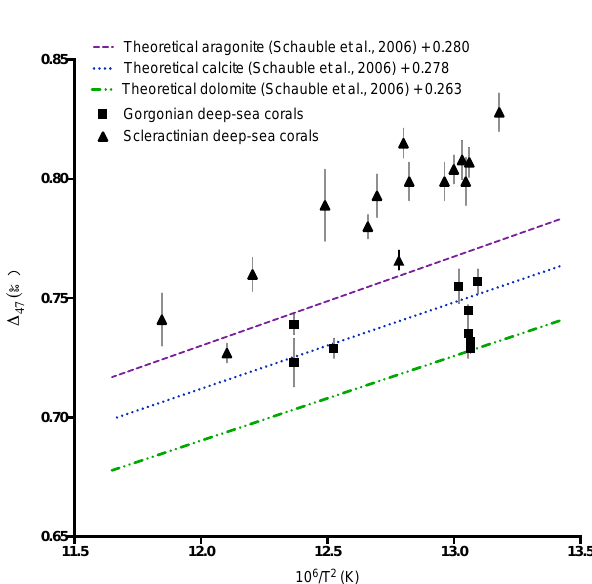
Figure 5. Scleractinian and gorgonian corals from this study and Thiagarajan et al. (2011) are compared to the theoretical predictions for (cid:49) 63 for aragonite, calcite, and dolomite. Acid fractionation val- ues were added to convert to (cid:49) 47 .